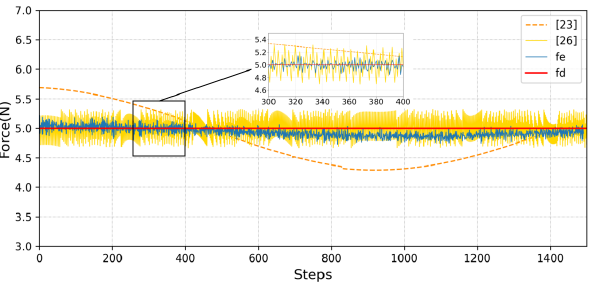
Figure 8. Performance comparison where [23] represents the contact force obtained using the manip- ulator under the control of the adaptive variable impedance method and [26] represents the contact force obtained using the manipulator under force control based on deep reinforcement learning.